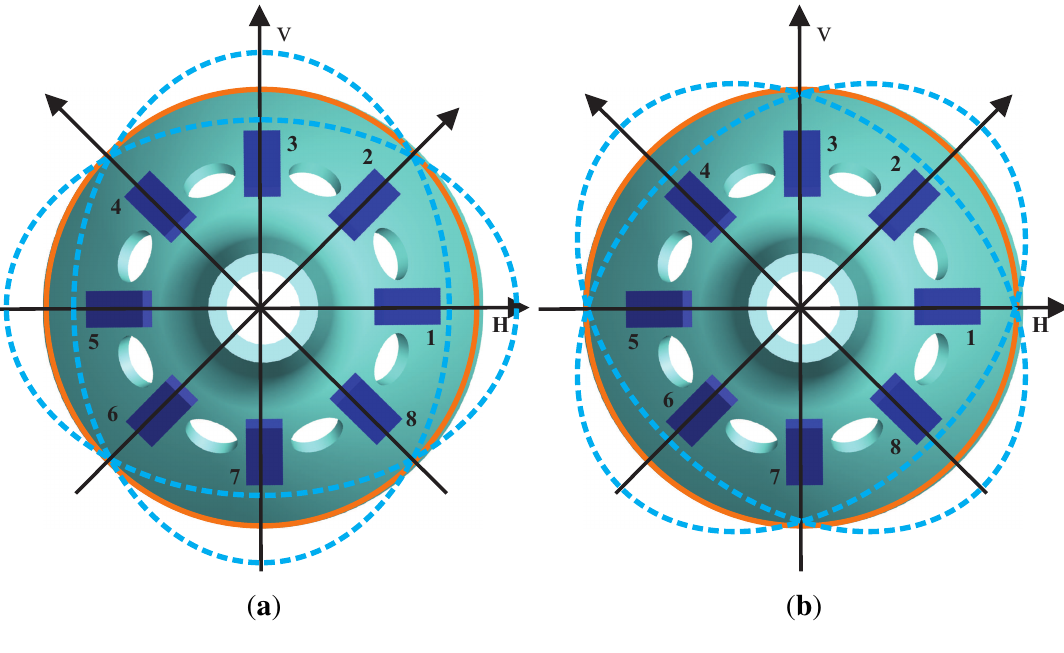
Figure 5. Schematic of the working principle. ( a ) Primary Mode. ( b ) Second Mode.